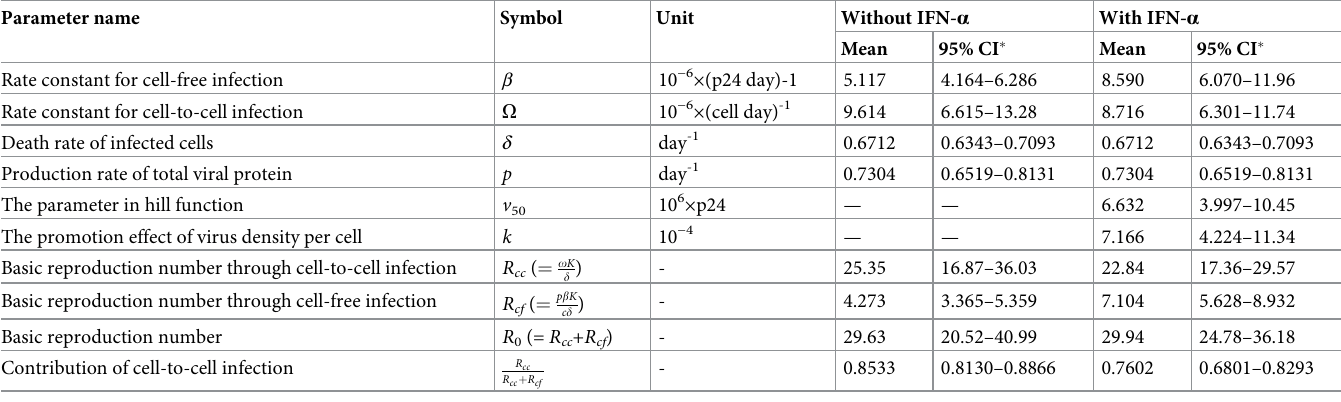
Table 1. Estimated parameters fitting the experimental data of HIV-1 strain NL4-3 by Model 1.